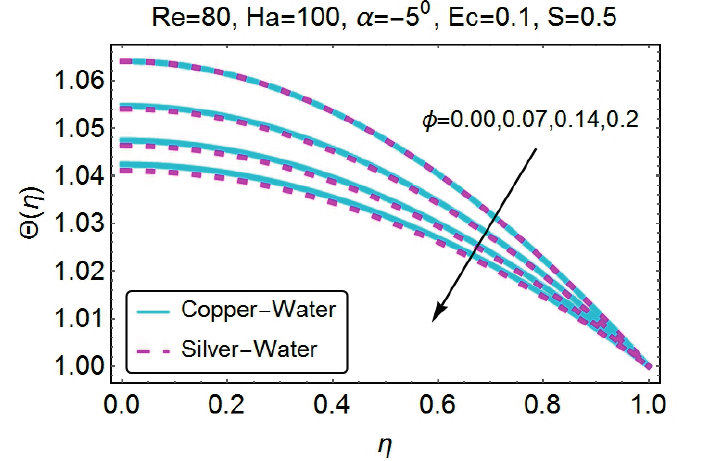
Figure 18. Change in temperature for varying ϕ (convergent channel/stretching